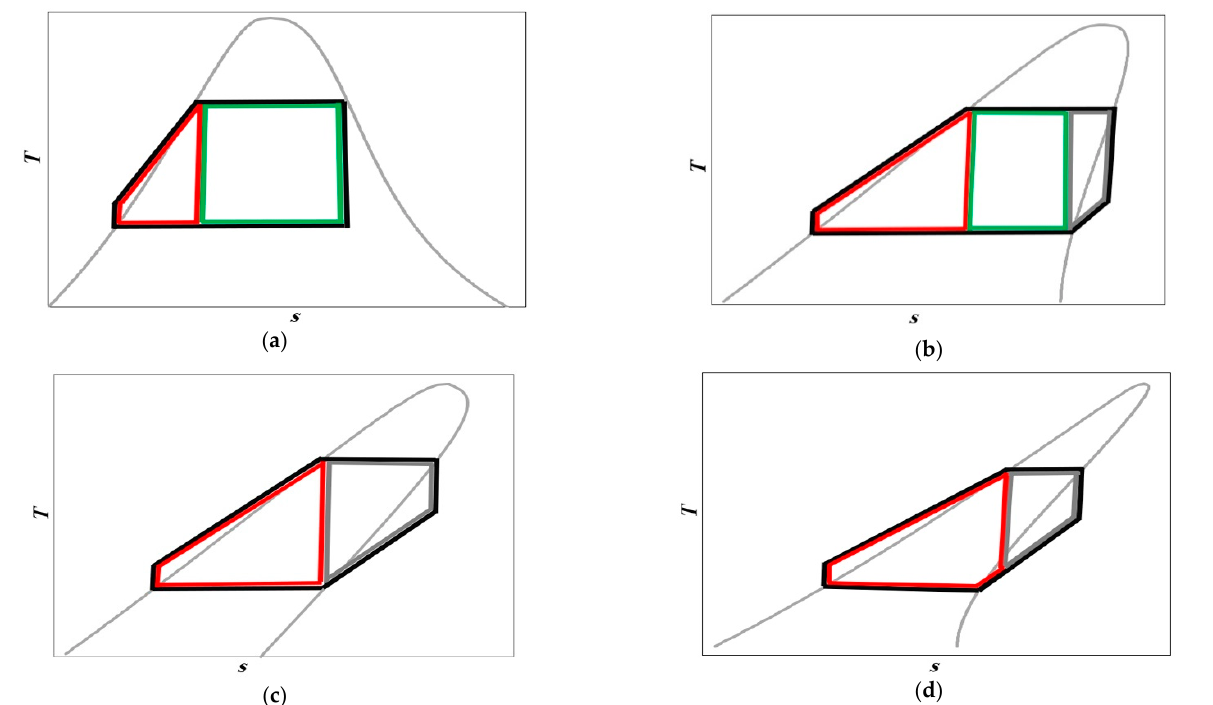
Figure 9. Different structure of an ORC cycle (black) with a wet, moderately dry, a medium dry and a very dry working fluid, divided into TFC-like (red), Carnot-like (green) and inverse TFC-like (grey) sub-cycles. The diminishment of the Carnot-like part (green) with increasing dryness can be clearly seen, as well as the loss of triangularity of TFC (red) and the appearance of the inverse TFC-like type (grey). The four figures are representing wet ( a ), moderately dry ( b ), medium dry ( c ) and very dry ( d ) working fluids.